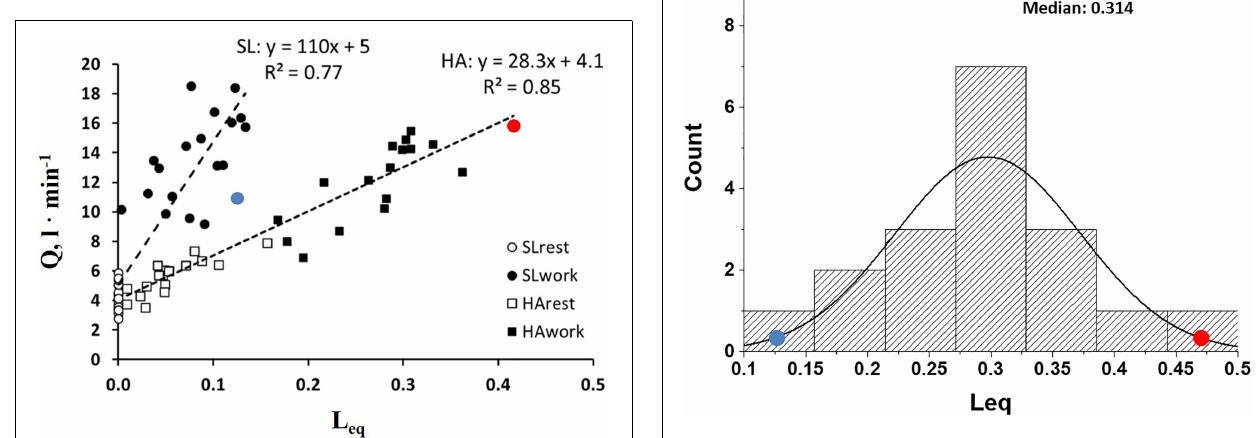
Frontiers in Physiology |